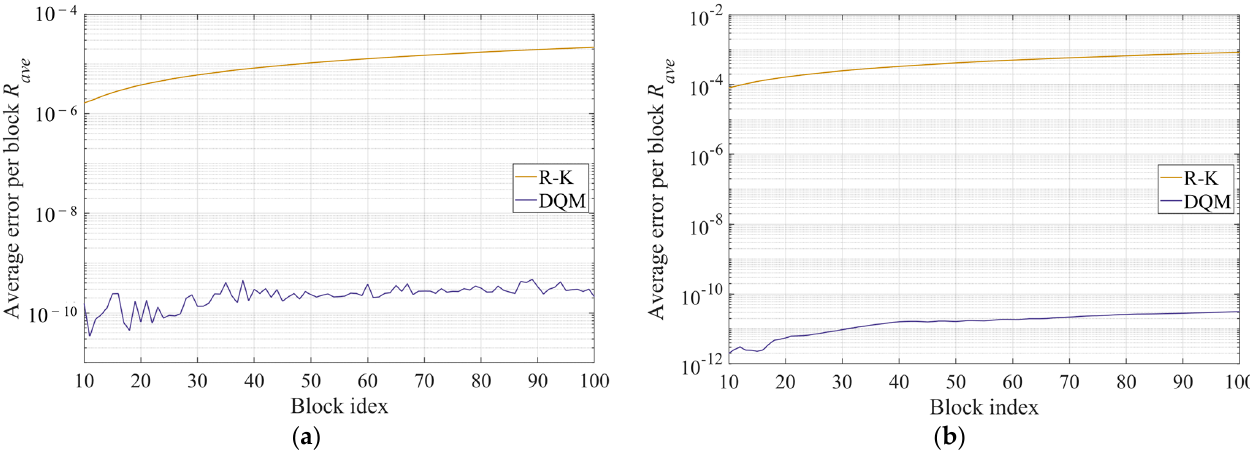
Figure 6. Error comparison between DQM and R–K: ( a ) Equation (70) and ( b ) Equation (71).